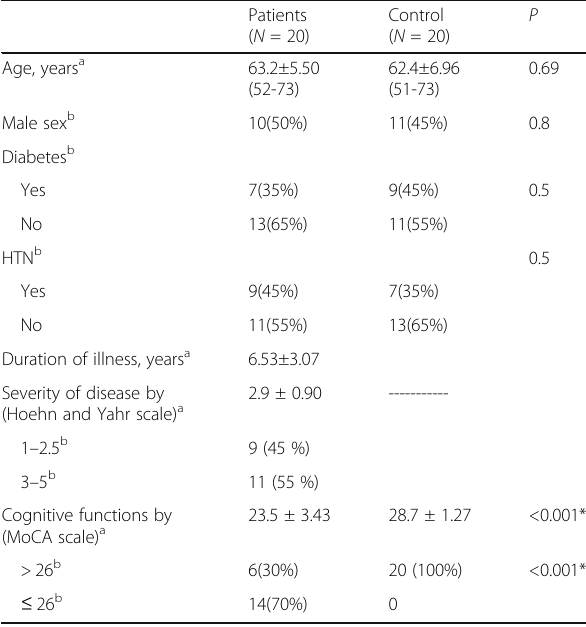
Table 1 Demographic data of the study